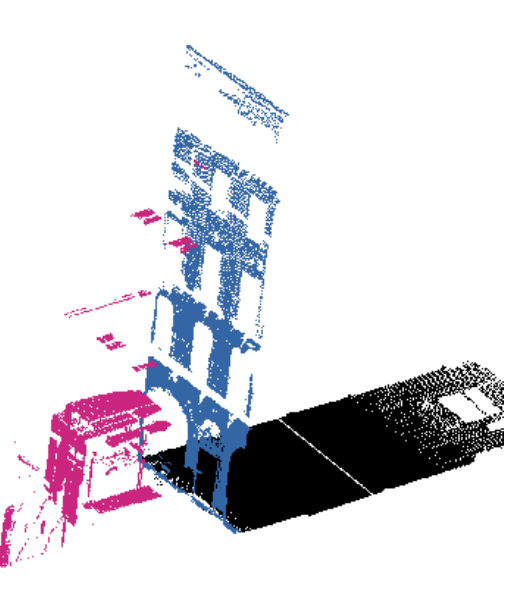
Figure 11. Indoor points detected from an outdoor scan, pink: the detected points, blue : inliers of the vertical plane that represents the fac¸ade 3.1.2 Ray Tracing Once the fac¸ades are detected, we